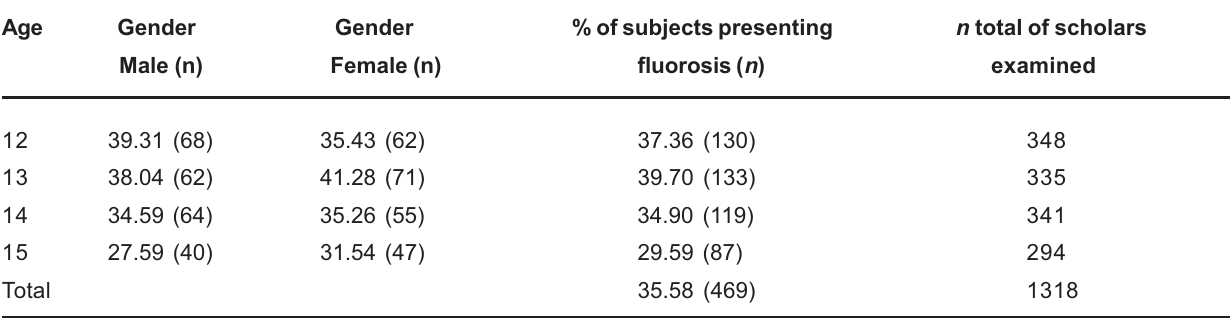
TABLE 2- Distribution of dental fluorosis according to age and gender, and total of scholars examined in Bauru, 2004